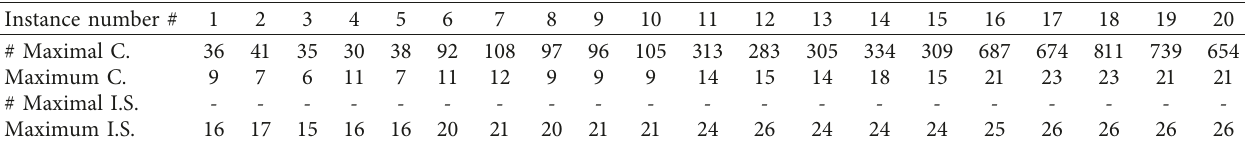
Table 5: Maximal cliques and maximal independent sets obtained with the Bron–Kerbosch algorithm for the instances #1–#20 in Table 1 using a radial coverage value of